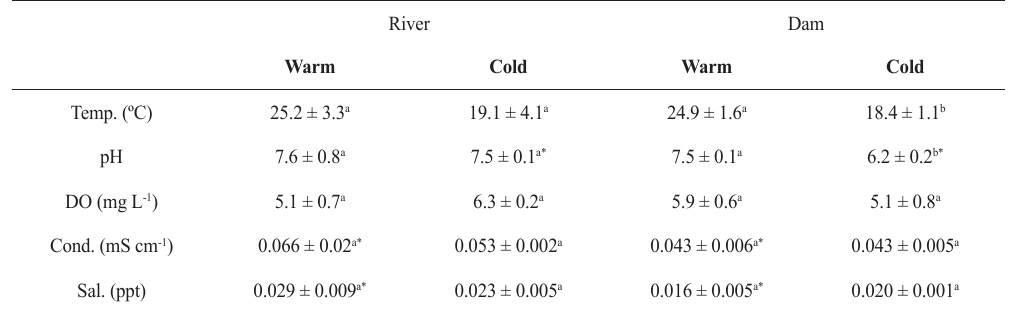
Table 1. Means of physicochemical parameters of water found in the sites and seasons of studied period. Different letters in a row represent significant differences between seasons of an environment (river or dam). Asterisks represent significant differences between environments in a same season. By one-way ANOVA unpaired t test with Welch’s corrections.